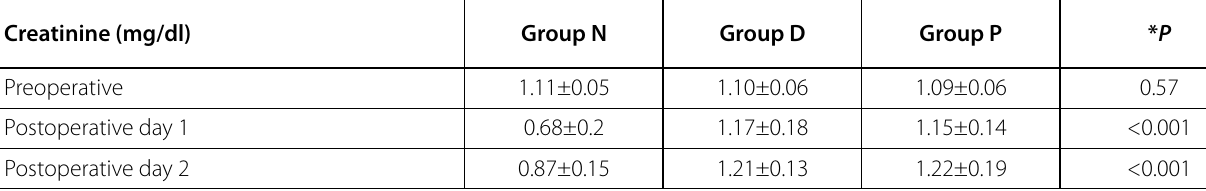
Table 6. Evaluation of creatinine with